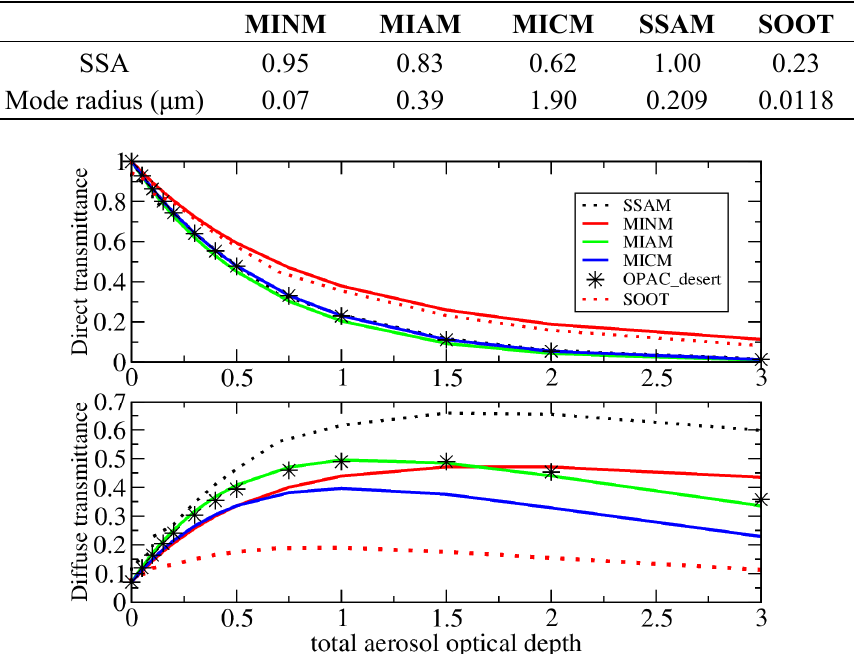
Figure 1. Direct ( top ) and diffuse ( bottom ) transmittance for the OPAC aerosol components used in this article (MIneral Nuclei Mode (MINM), MIneral Accumulation Mode (MIAM), MIneral Coarse Mode (MICM), Sea Salt Accumulation Mode (SSAM) and soot component (SOOT)) and the desert aerosol type (OPAC_desert is a combination of MINM, MIAM and MICM). A solar zenith angle of 50° was set to calculate all transmittances, as it corresponds to the average value in West Africa during the dry